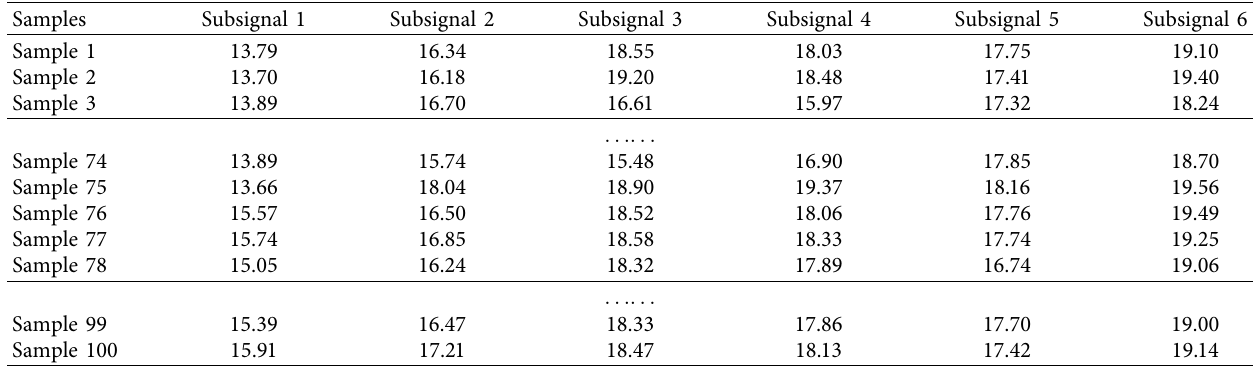
Table 2: The Renyi entropy values for the experimental